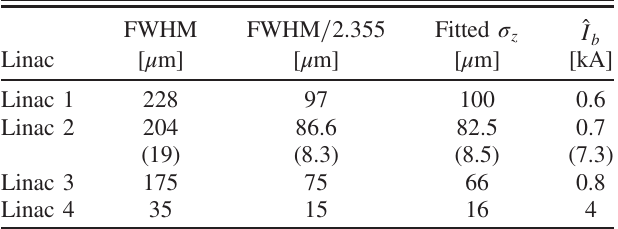
TABLE II. Parameters characterizing the longitudinal bunch profile for each linac passage: full-width-half-maximum (FWHM), FWHM divided by 2.355 (equal to a standard deviation σ for a Gaussian profile), the rms bunch length σ z obtained from a Gaussian fit, and the peak current. The numbers in parentheses refer to the 20 GeV